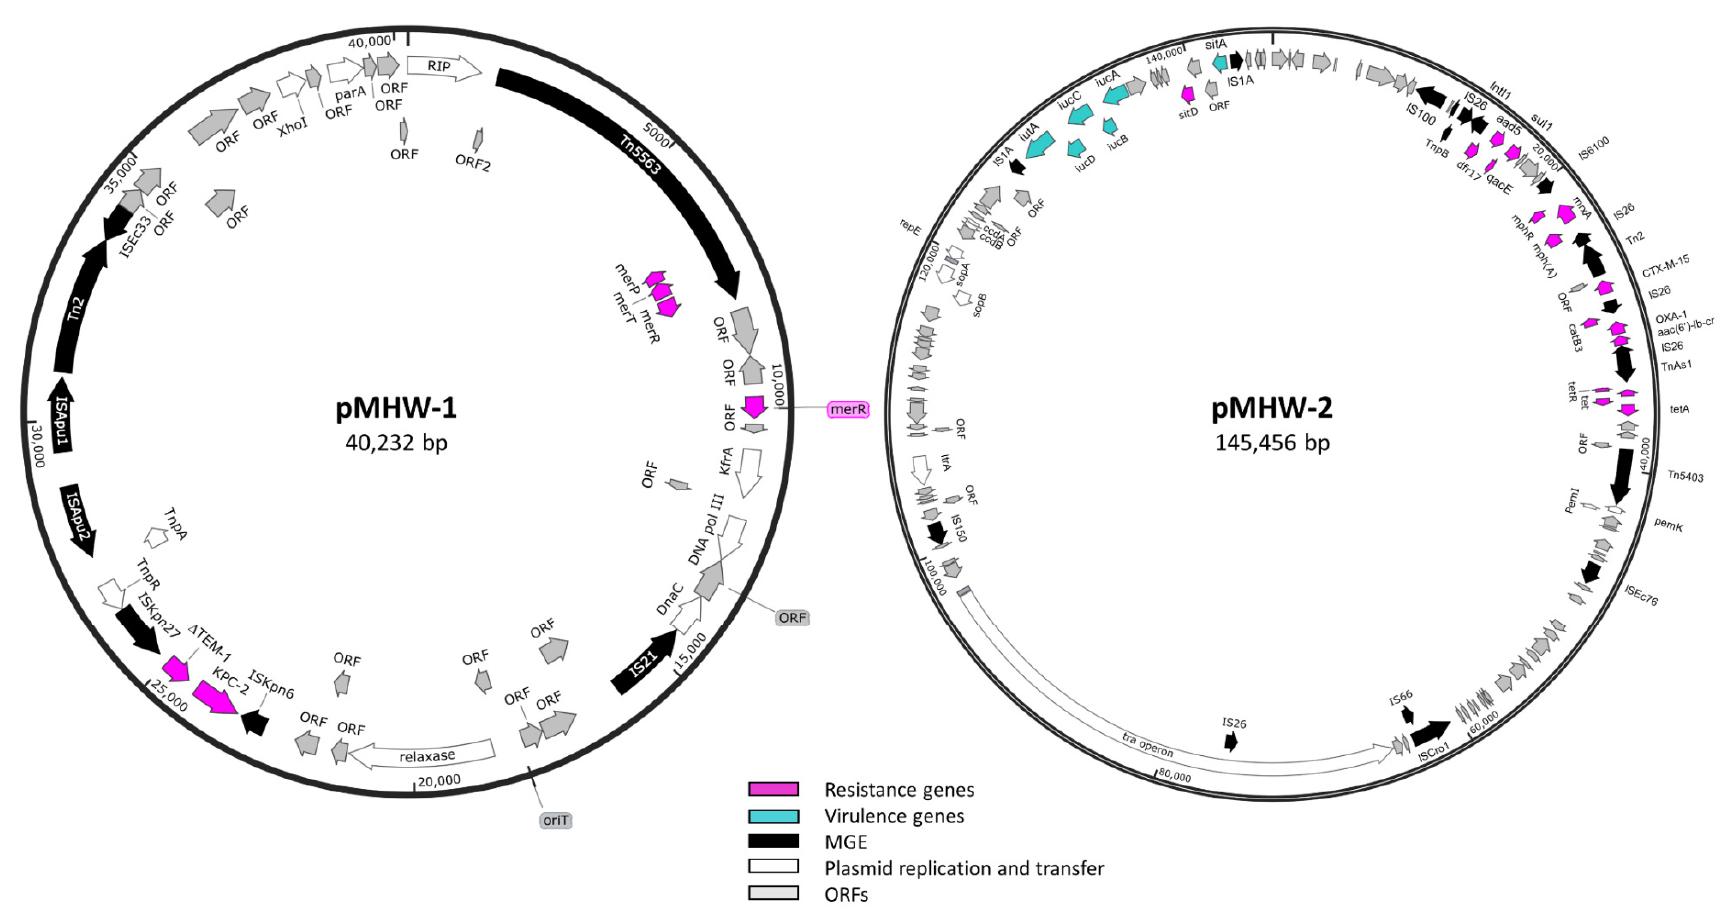
Figure 3. Plasmid maps from hospital wastewater E. coli 1000C-3 isolate. Plasmids sequences were determined from long-read Nanopore and Illumina short paired-end reads. pMHW-1 was identified as a 40,232 bps mobilizable IncP-6-type plasmid, and pMHW-2 as a 145,456 bps conjugative IncF plasmid containing a tra operon. Arrows are color-coded exhibiting genes involved in drug resistance (fuchsia), virulence (blue), mobile genetic elements (MGE) (black), plasmid replication, maintenance and transfer (white), and opening reading frames (ORFs) (grey).